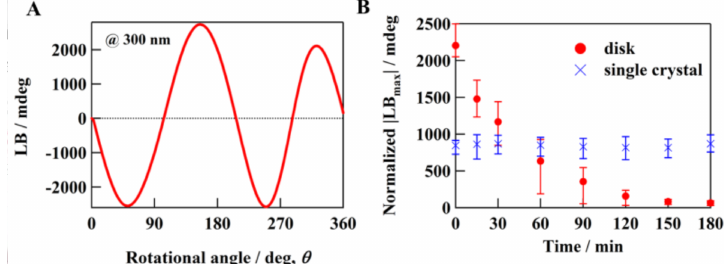
Figure 1. ( A ) Linear birefringence (LB) rotational measurement of KBr disk at 300 nm; ( B ) Recovery process of stress-induced LB values (@ 300 nm) of KBr disk (circle) and single crystal (x) at plus LB max positions; LB values normalized with respect to sample